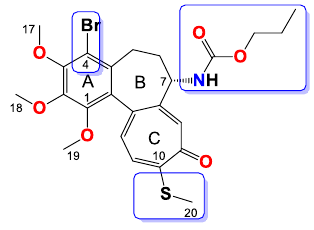
Figure 9. Structure of compound 9 .